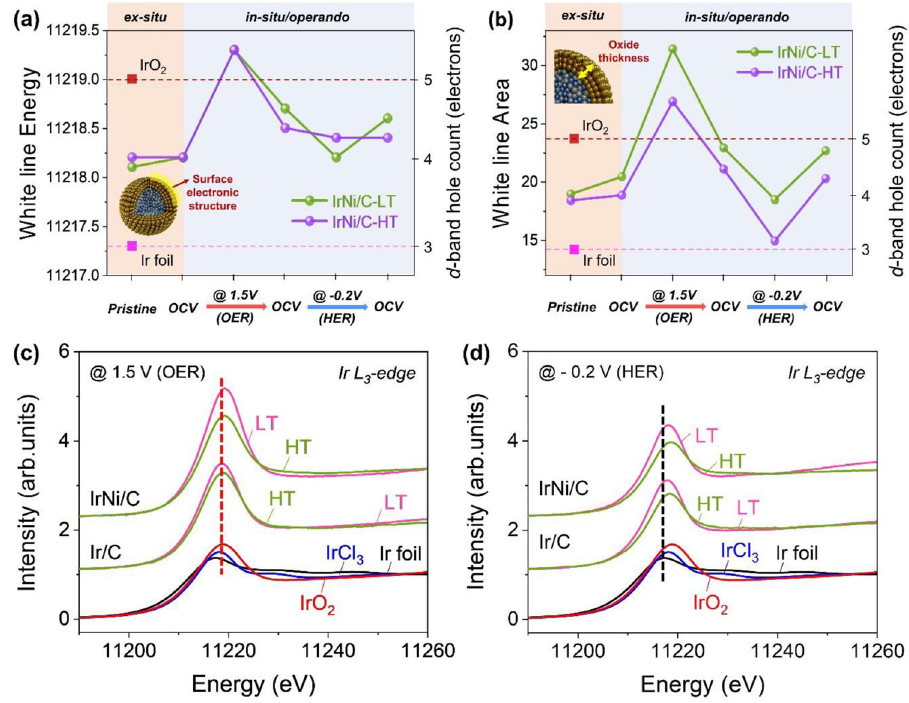
Fig. 3 In situ /operando study of Ir-based electrocatalysts for electronic structure and oxide thickness analysis. Ir L3-edge XANES of synthesized catalysts measured under the experimental sequence: (i) pristine electrocatalysts powder, (ii) spray coated on electrode in 0.05 M H 2 SO 4 at OCV, (iii) OER operating condition at 1.5 V RHE , (iv) OCV after OER operation, (v) HER operating condition at – 0.2 V RHE , (vi) OCV after HER operation. ( a ) The white- line peak energy and ( b ) area of IrNi/C-LT and IrNi/C-HT are illustrated. Commercial Ir black and IrO 2 were measured as references under same conditions. Ir L 3 -edge XANES spectra of synthetic catalyst during ( c ) OER and subsequent ( d ) HER conditions. XANES spectra under other experimental conditions are shown in Supplementary Figs. 18 and